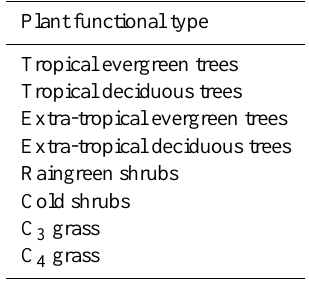
Table 1. List of plant functional types (PFTs) defined in the land surface scheme JSBACH.